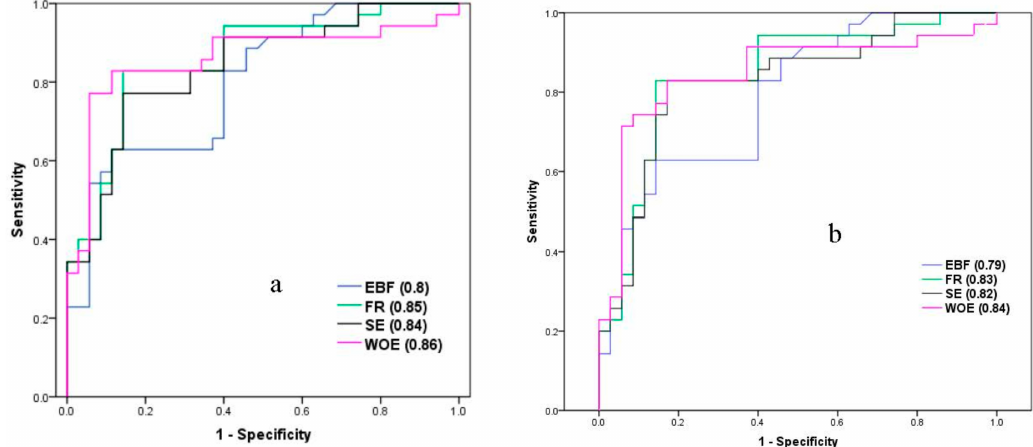
Figure 6. Model validation for Klijanrestagh Watershed: ( a ) success rate curve and ( b ) prediction rate